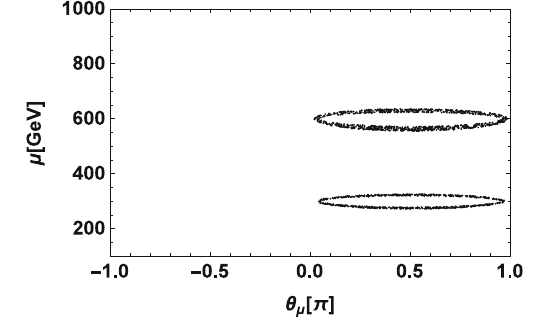
Fig. 3 Keeping Y B in the region ( 8 . 2 − 9 . 4 ) × 10 − 11 , the allowed region of θ μ and μ